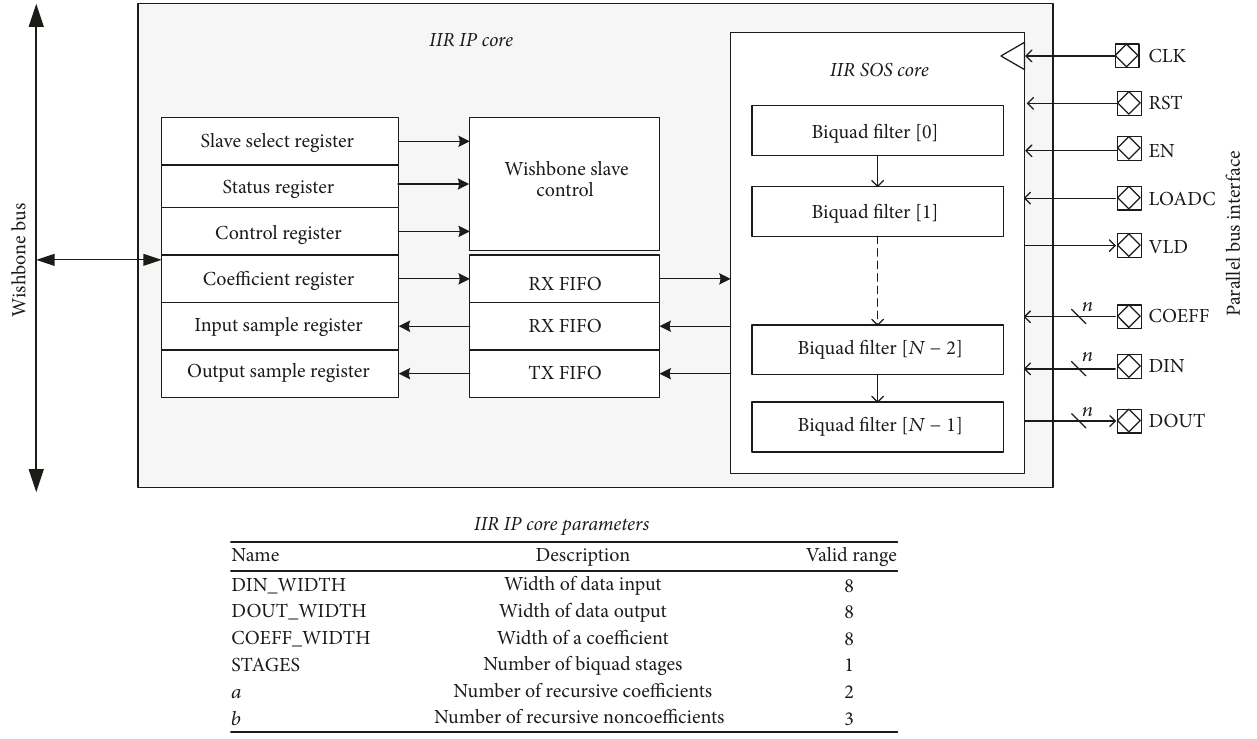
Figure 5: An architecture of the IIR IP